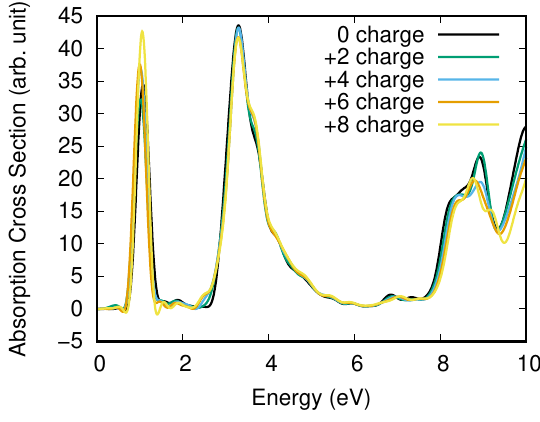
Figure 1. Absorption spectra of a SWCNT when electrons are removed from